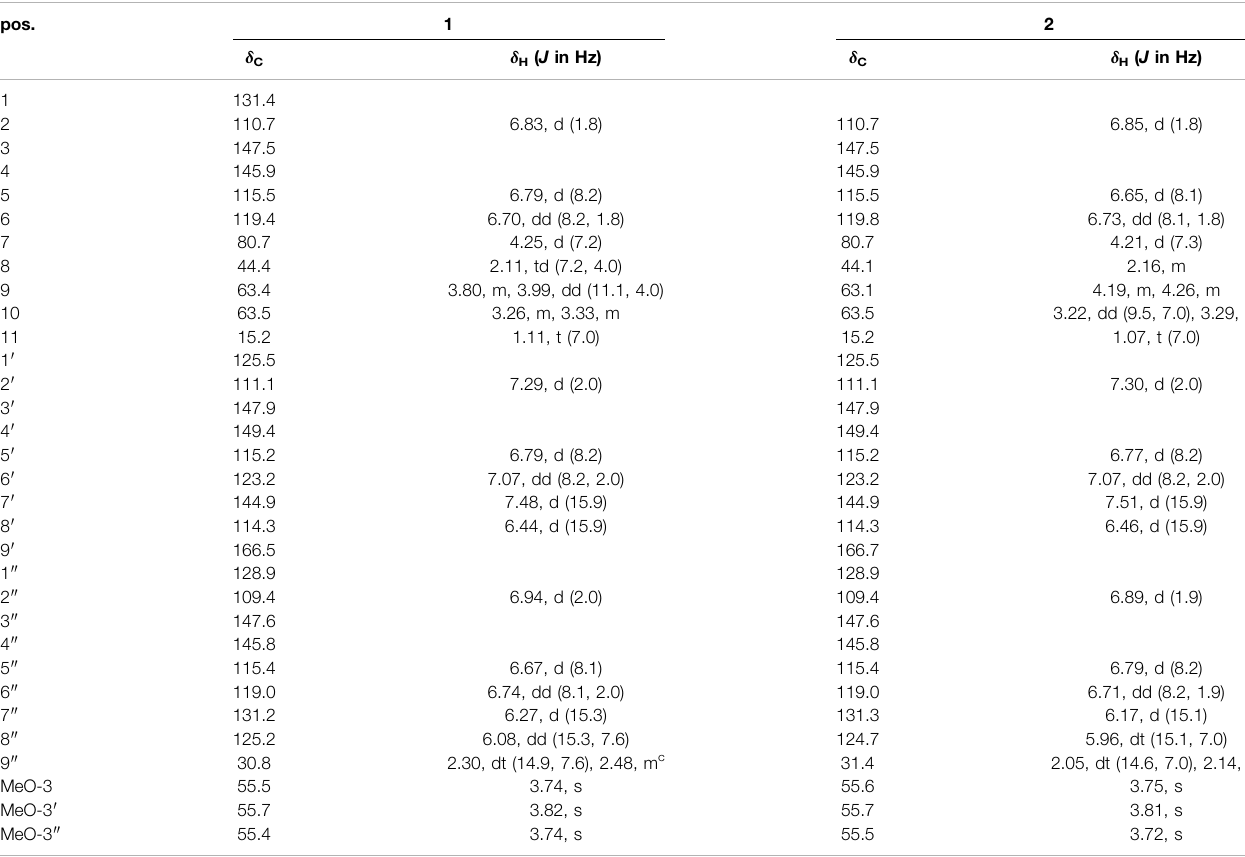
TABLE 1 | 1 H and 13 C NMR data (DMSO- d 6 ) for compounds 1 a and 2 b .